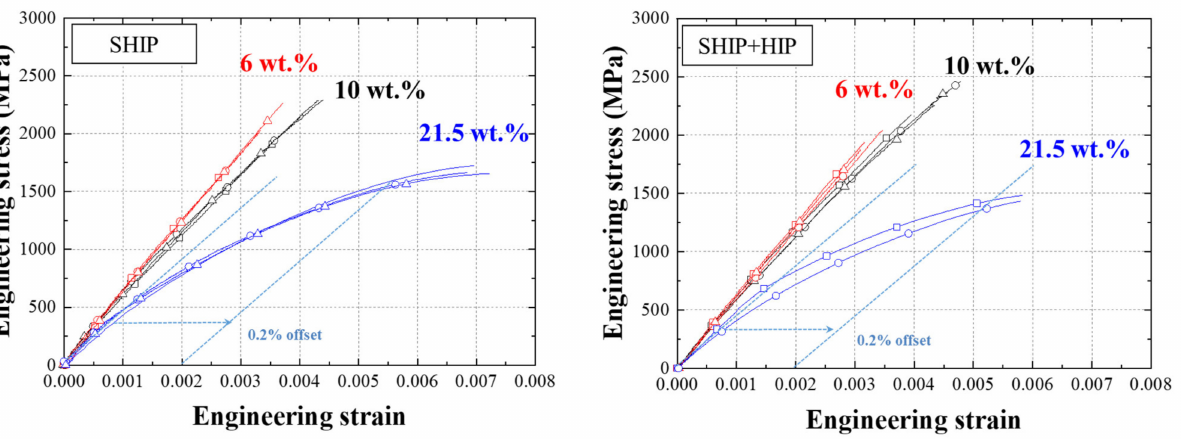
Figure 9. Comparison of the tensile test result of WC-Co according to the Co content and HIP